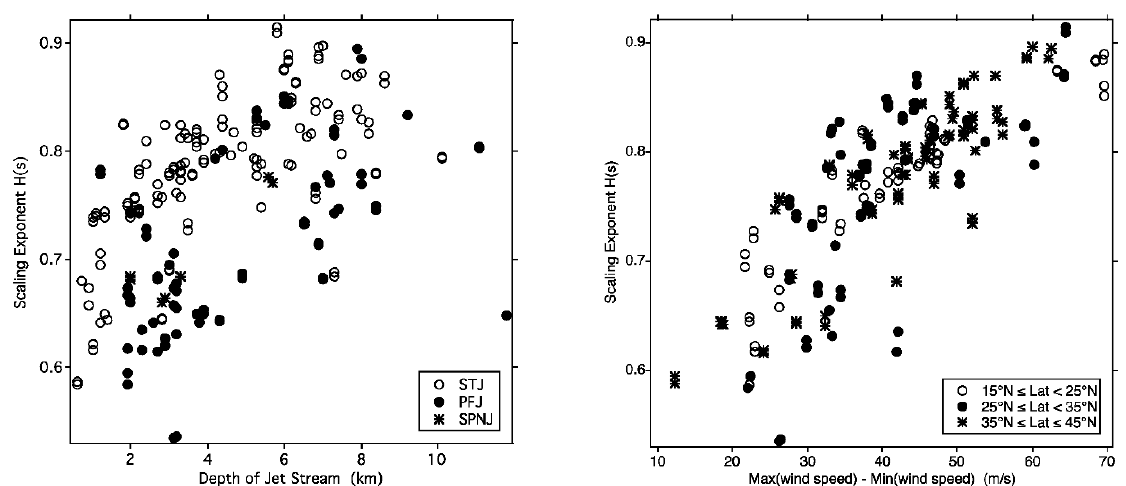
Figure 4. Left, vertical scaling exponent H from GPS dropsondes released from the NOAA G4 aircraft flying at 13 km over the northeastern Pacific Ocean, Winter Storms missions 2004, 2005, 2006 [12], plotted against the depth of the jet stream observed by the sondes. STJ, subtropical jet stream; PFJ, polar front jet stream; SPNJ, stratospheric polar night jet stream. Right, H for horizontal wind speed observed from the dropsondes plotted against the vertical difference between the maximum and minimum wind speeds seen by the sondes.